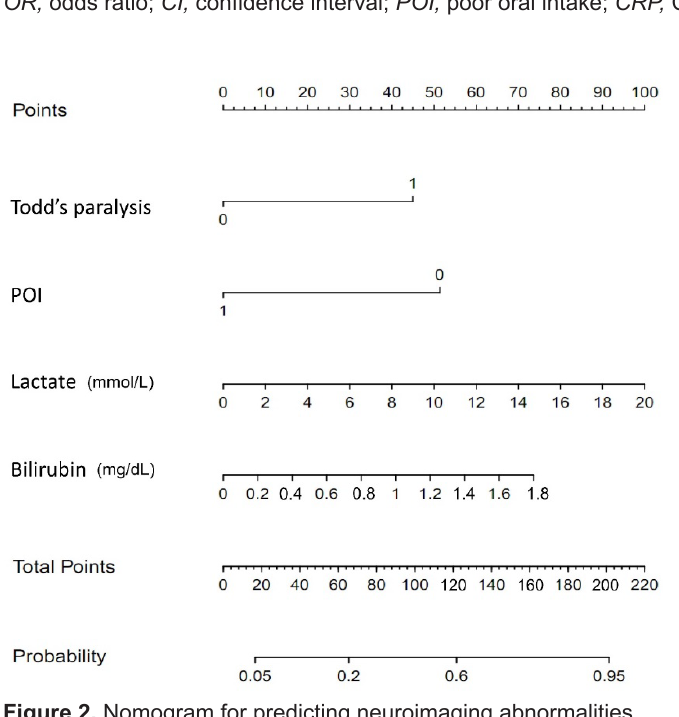
Figure 2. Nomogram for predicting neuroimaging abnormalities in pediatric patients experiencing their first afebrile seizure. Each factor was rated on the top visible point scale (0–100), and the probability of neuroimaging abnormalities was predicted by sum - ming the scores of all factors. For example, a patient with Todd’s paralysis and a bilirubin level of 1.0 mg/dL would have 45 and 40 points for each factor. After summing the scores, total points are 85, and the probability of neuroimaging abnormalities would be 0.4 for the